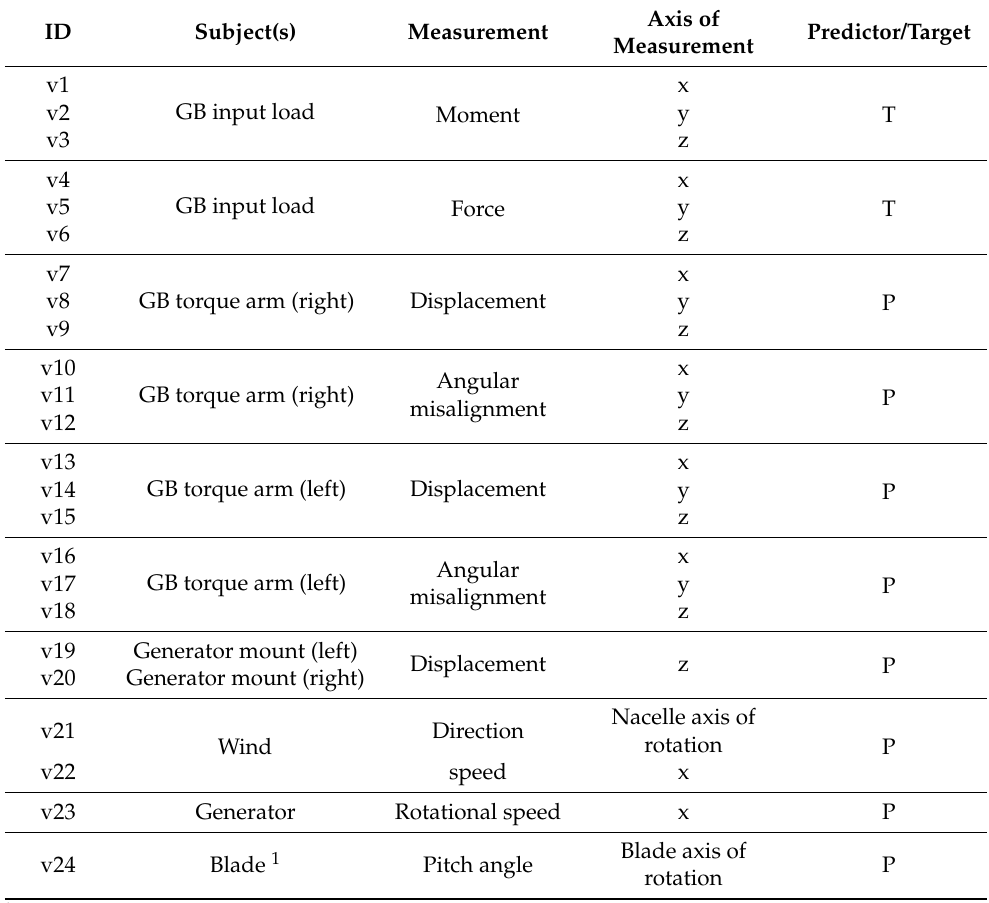
variable. Figure 1 indicates the orientations of the x, y, and z axes of measurement with respect to the WT drivetrain during the simulation. Table 1. Available variables and their respective attributes.